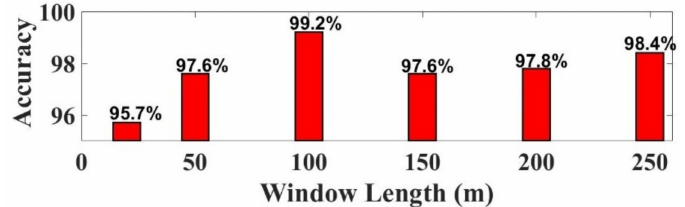
Figure 9. Accuracy comparison plot for various values of ‘m’.